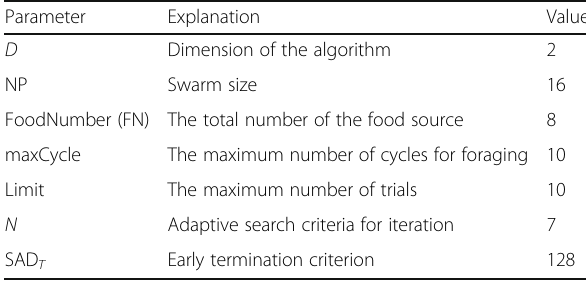
Table 2 Parameters of ABC